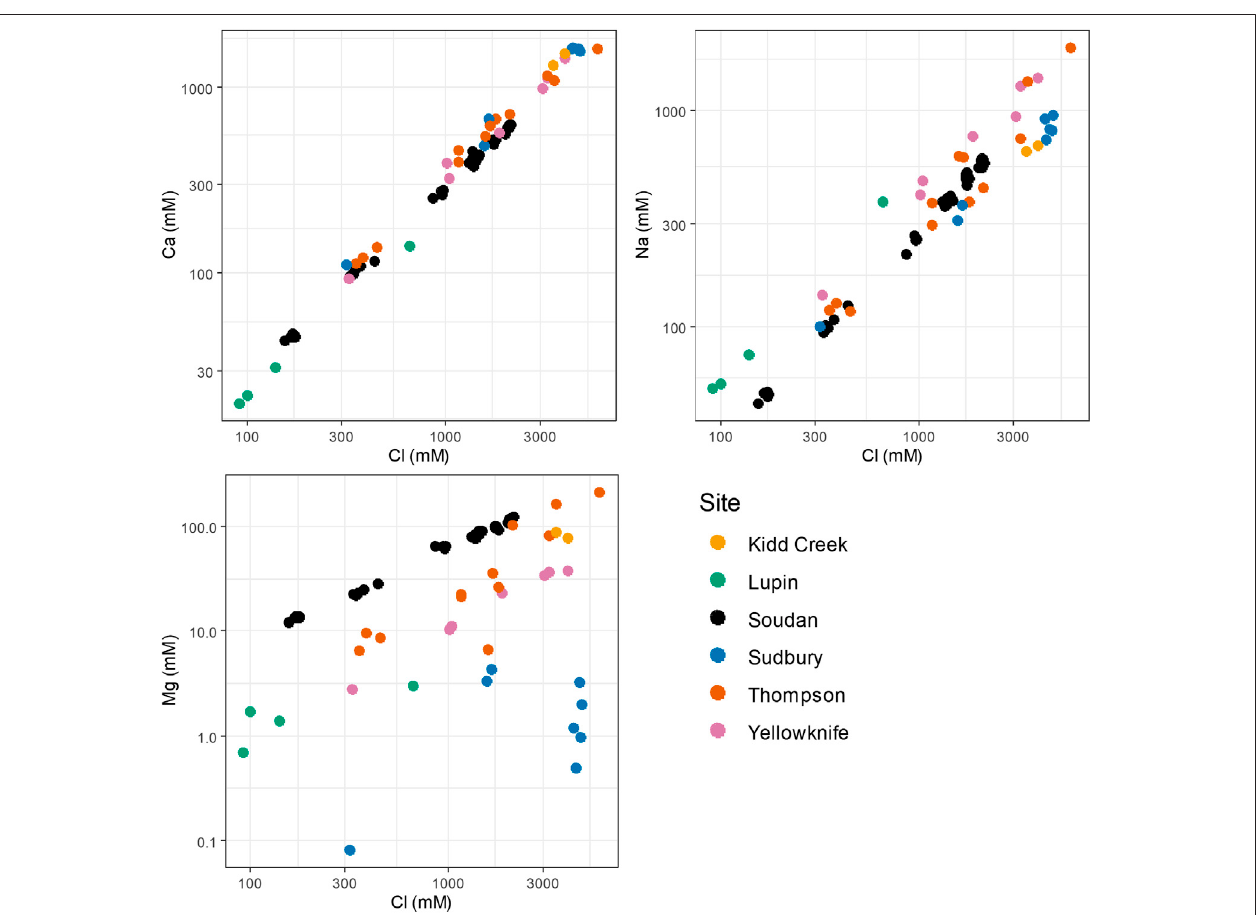
FIGURE7| VariationinmajorionconcentrationsamongCanadianShieldsites.Amapshowingthelocationsofthesesitescanbeseenin SupplementaryFigure S6 . Kidd Creek (Timmins, ON, Canada) data were published in (Lollar et al., 2019). Lupin (Nunavut Territory, Canada) data were published in (Onstott et al., 2009). Sudbury Basin (ON, Canada) and Yellowknife (Northwest Territiries, CA) data were published in (Fritz and Frappe, 1982) and (Frape et al., 1984). Thompson (MB, Canada) data were published in (Fritz and Frappe, 1982), (Frape et al., 1984), and (Telling et al., 2018).